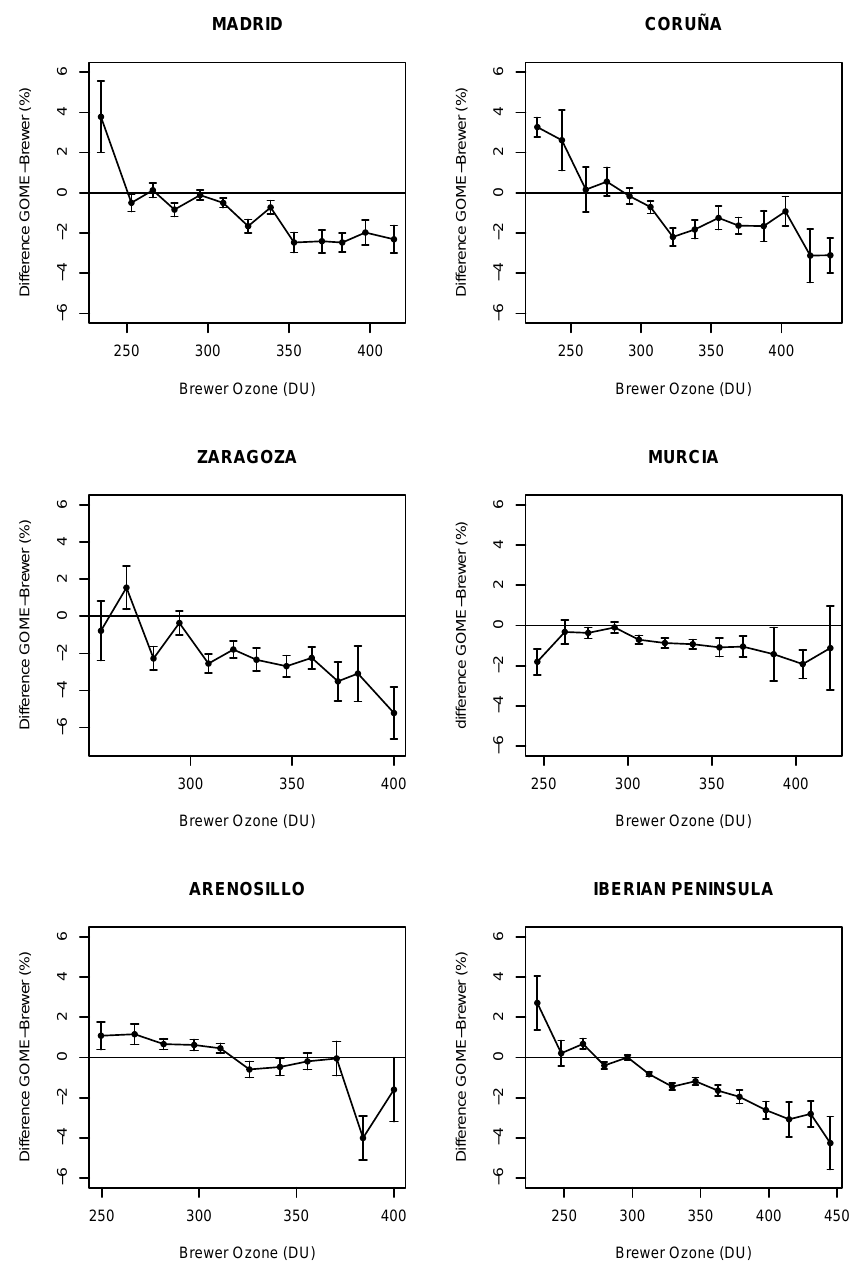
Fig. 10. Variation of GOME-Brewer relative differences with Brewer ozone